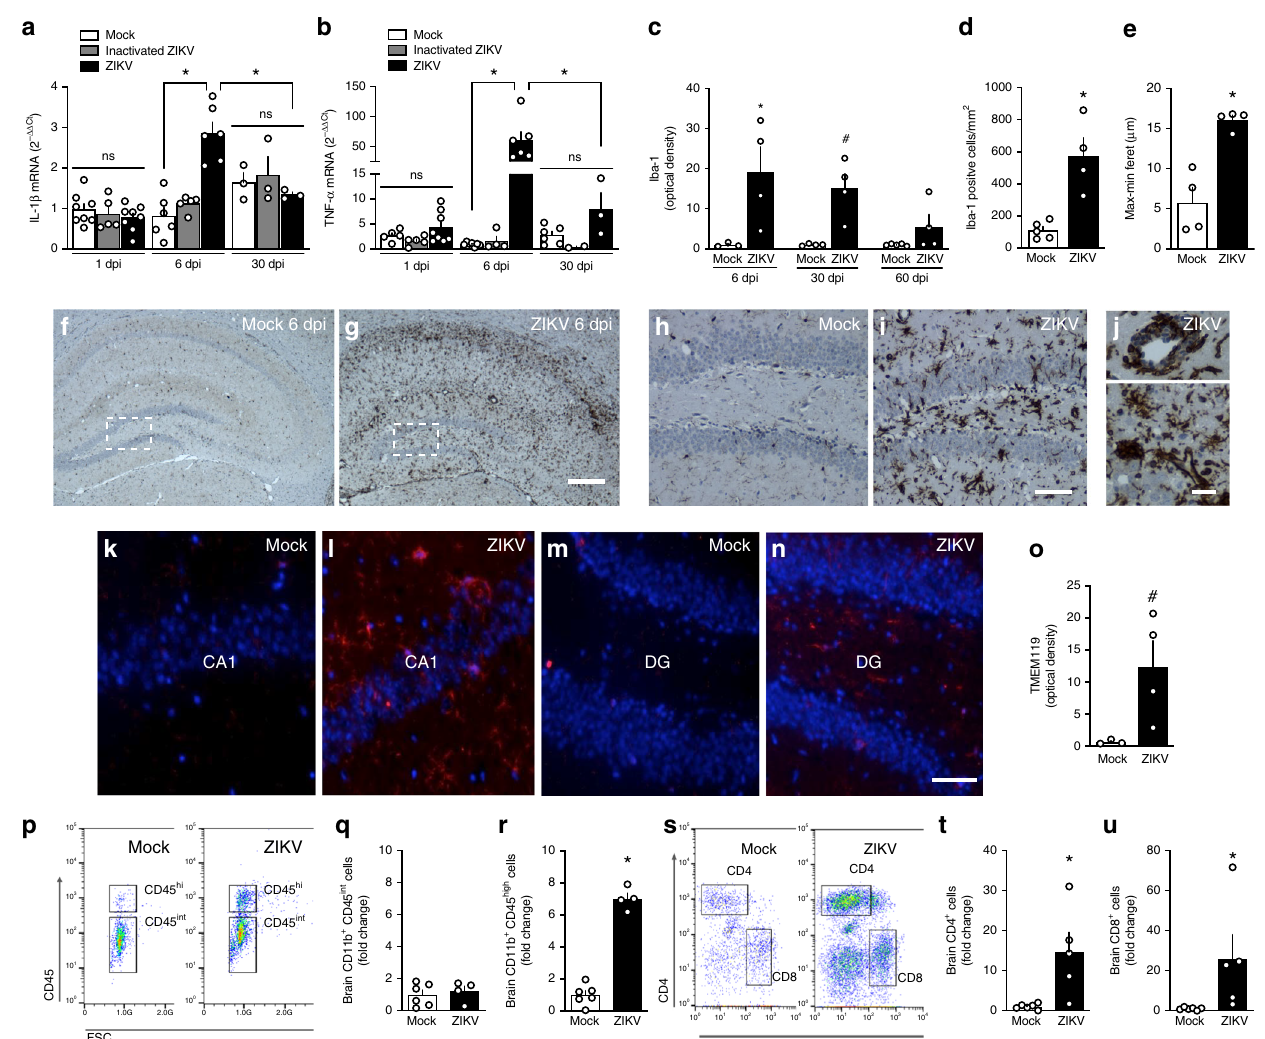
Fig. 4 ZIKV triggers brain in fl ammation and microgliosis in adult mice. Adult mice received an i.c.v. infusion of 10 5 PFU ZIKV, UV-inactivated ZIKV or mock medium. a Brains were processed for determination of the expression of IL-1 β ( a F(2,38) = 4.878, * p <0.0001, ZIKV-infected vs mock-infused mice at 6dpi, two-way ANOVA followed by Bonferroni; N = 8 (1 dpi), 6 (6 dpi), and 3 (30 dpi) (mock); 5 (1 and 6 dpi) and 3 (60 dpi) (inactivated-ZIKV); and 8 (1 dpi), 6 (6 dpi) and 3 (30 dpi) (ZIKV)mice) or TNF- α ( b F(2,37) = 13.62, * p < 0.0001, ZIKV-infected vs mock-infused mice at 6 dpi; two-way ANOVA followed by Bonferroni; N = 5 (1 dpi), 7 (6 dpi) and 6 (30 dpi)(mock); 5 (1 dpi), 4 (6 dpi), and 2 (60 dpi) (inactivated-ZIKV) and 8 (1 dpi), 6 (6 dpi) and 3 (60 dpi) (ZIKV)mice. c Integrated Iba-1 immunoreactivities (optical density) in the hippocampi of ZIKV-infected mice at 6, 30, or 60 dpi (F(2,10) = 0.2612, 6 dpi: * p = 0.0110, 30 dpi: # p = 0.0554; two-way ANOVA followed by Bonferroni compared to mock-infused mice at the same time point; N = 3 (mock) and 4 (ZIKV) mice at 7 dpi; 4 mice/group at 30 dpi and 5 (mock) and 4 (ZIKV) mice at 60 dpi). d Iba-1 positive cells in the hippocampi of mice at 6 dpi (t = 4.507; * p = 0.0028; Student ’ s t -test; N = 5 (mock)and 4 (ZIKV) mice). e Maximum-minimum Feret index in microglia in hippocampi of mock-infused or ZIKV-infected mice at 6dpi (t = 5.205; * p = 0.002; N = 4 mice/group). f , g Representative images of Iba-1 immunoreactivity in the hippocampi of mock- infused ( f ) or ZIKV-infected ( g ) mice at 6dpi. Scale bar = 300 μ m. h , i Higher magni fi cation images of the regions de fi ned by dashed white rectangles in panels f and g , respectively. Scale bar = 50 μ m. j Representative images illustrating perivascular cuf fi ngs (top) and microglial nodules (bottom) in hippocampi of ZIKV-infused mice at 6 dpi. Scale bar = 20 μ m. k – n Representative images of TEMEM119 immunolabeling in hippocampal CA1 region ( k, l ) and in DG ( m, n ) of mock-infused or ZIKV-infected mice at 6dpi. Scale bar = 50 μ m. o Integrated TMEM119 immunoreactivities (optical densities) in the hippocampi of mice at 6 dpi (t(1,5) = 2.435; # p = 0.059, Student ’ s t -test); N = 3 (mock) and 4 (ZIKV) mice. Bars represent means ± SEM. Symbols correspond to individual mice. p – r Representative dot plot ( p ) and frequency of quiescent microglia (CD11b + CD45 int cells; q , and activated myeloid cells (CD11b + CD45 high cells; r in brains of mock- or ZIKV-infused mice at 6 dpi ( q N = 6 (mock) and 4 (ZIKV) mice; r t = 14.03; * p < 0.0001; Student ’ s t -test; N = 6 (mock) and 4 (ZIKV) mice). s – u Representative dot plot ( s ) and frequencies of CD4 ( t ) and CD8-positive ( u ) cells in brains of mock- or ZIKV-infused mice at 6 dpi ( t t = 3.072; * p = 0.0133; u t = 2.242; # p = 0.0517; N = 6 (mock) and 5 (ZIKV) mice; Student ’ s t -test). Bars represent means ± SEM; Symbols represent individual mice ( a – o ) or a pool of two mice ( p – u ). Source data from panels a – e , o, q, r, t , u are provided as Source Data